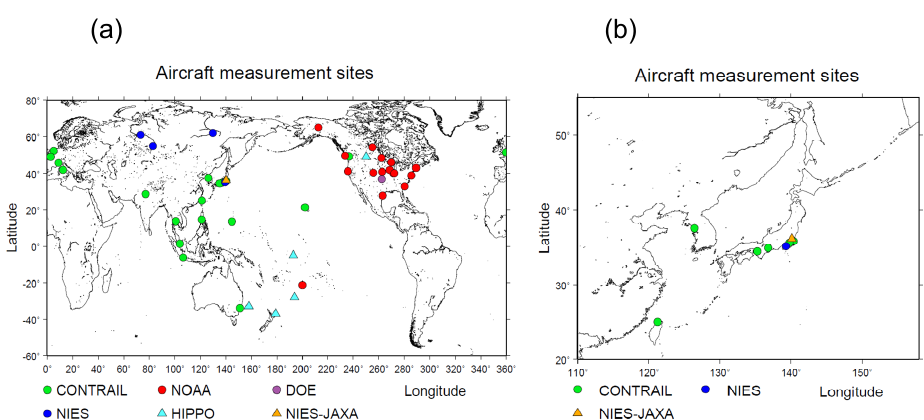
Fig. 1. (a) Location of aircraft observation sites used for GOSAT validation. The East Asian region is expanded in (b).